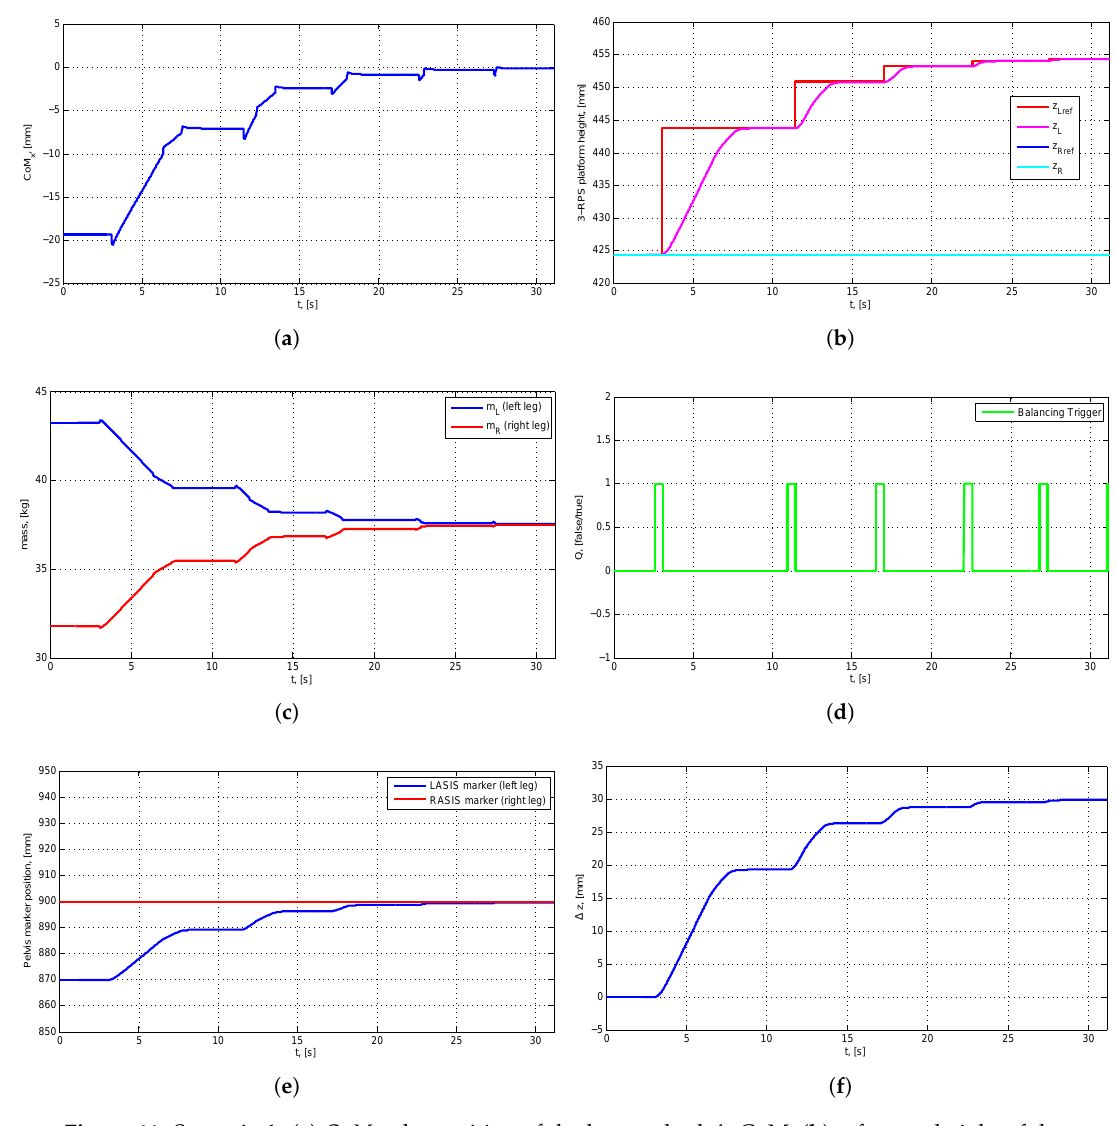
Figure 11. Scenario 1: ( a ) CoM x , the position of the human body’s CoM; ( b ) reference height of the left ( z Lref ) and right ( z Rref ) force plate, current height of the left ( z L ) and right ( z R ) force plate; ( c ) the load on the left ( m L ) and right ( m R ) leg; ( d ) the balancing trigger signal ( Q ) marking the start of a new HBBA iteration; ( e ) position of the LASIS and RASIS markers, which are located on the pelvis; and ( f ) left and right force plate height difference ( ∆ z ), which corresponds with the LLD evaluation ( ∆ l ) in the HBBA’s final